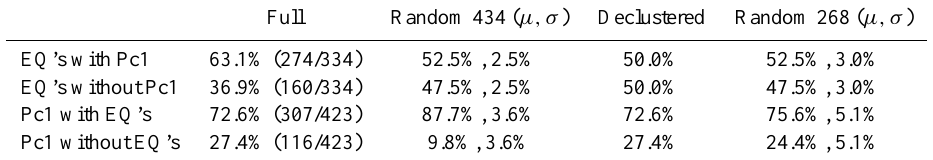
Table 1. Percentage of midday Pc1 pulsations with, and without, an earthquake ensuing within 2 weeks, and vice versa. Columns correspond to the full earthquake catalog (M ≥ 3, within 200km), the mean µ and standard deviation σ of 300 similar random event